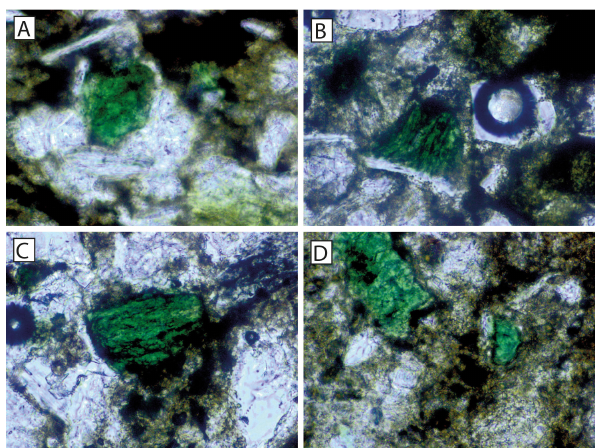
Figure 5. Microphotographs of glauconite grains in thin sections, (A) from 121.36mbs, (B) from 120.80mbs, and (C) and (D) from